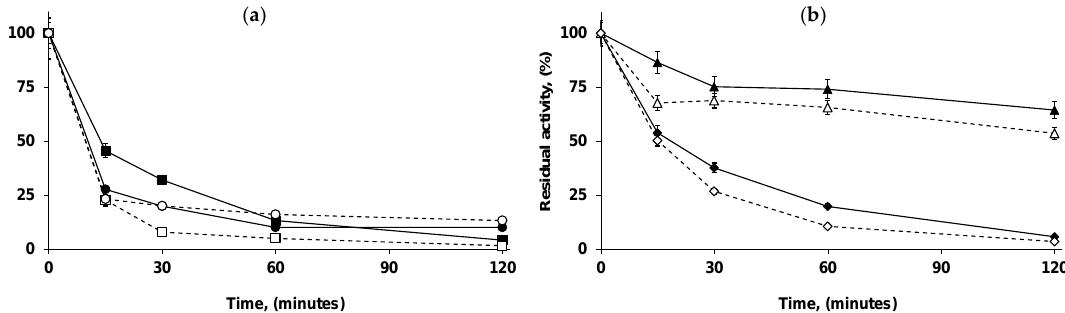
Figure 5. Effect of sodium phosphate in the inactivation courses of different enzyme formulations TLL-octyl, ET-octyl, free TLL, and free ET in the presence of phosphate anions. The biocatalysts were incubated in 100 mM of Tris-HCl or 100 mM of sodium phosphate at pH 7.0 and 72 °C. ( a ) TLL formulations inactivations, ( b ) ET formulations. Other specifications are described in the Methods section. Continuous lines and filled symbol: 100 mM Tris-HCl at pH 7.0; dotted lines and empty symbol: 100 mM sodium phosphate at pH 7.0; squares: TLL-octyl; circles: free TLL; triangles: ET-octyl; rhombus: free ET.